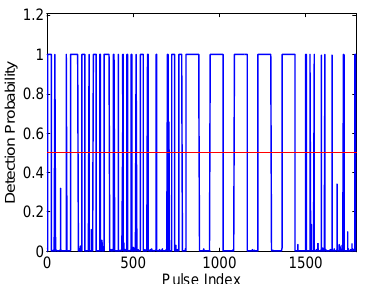
Figure 12. The detection probability of radar pulse before NBI mitigation, where the red line represents the threshold.